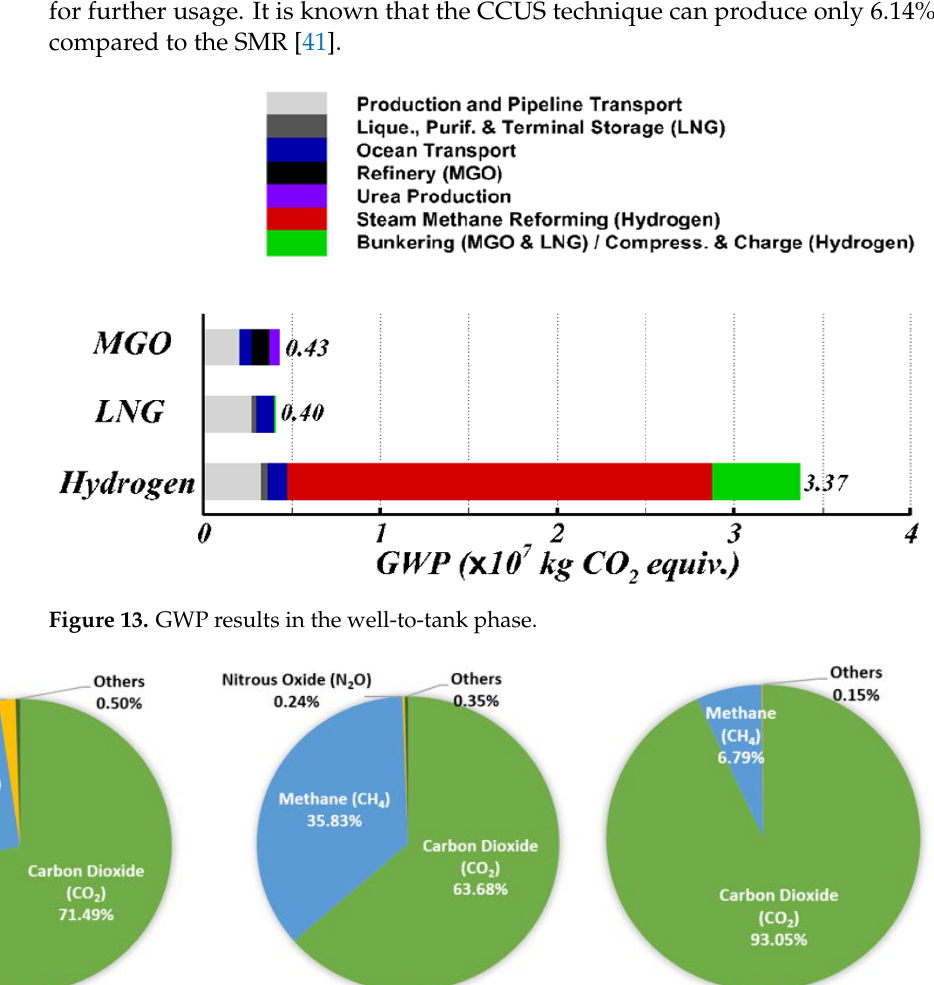
Figure 13. GWP results in the well-to-tank phase.